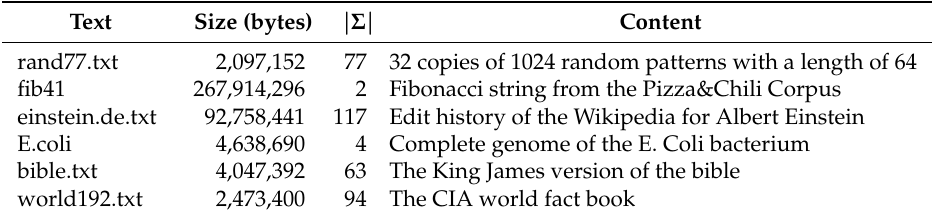
Table 1. Text files used in our